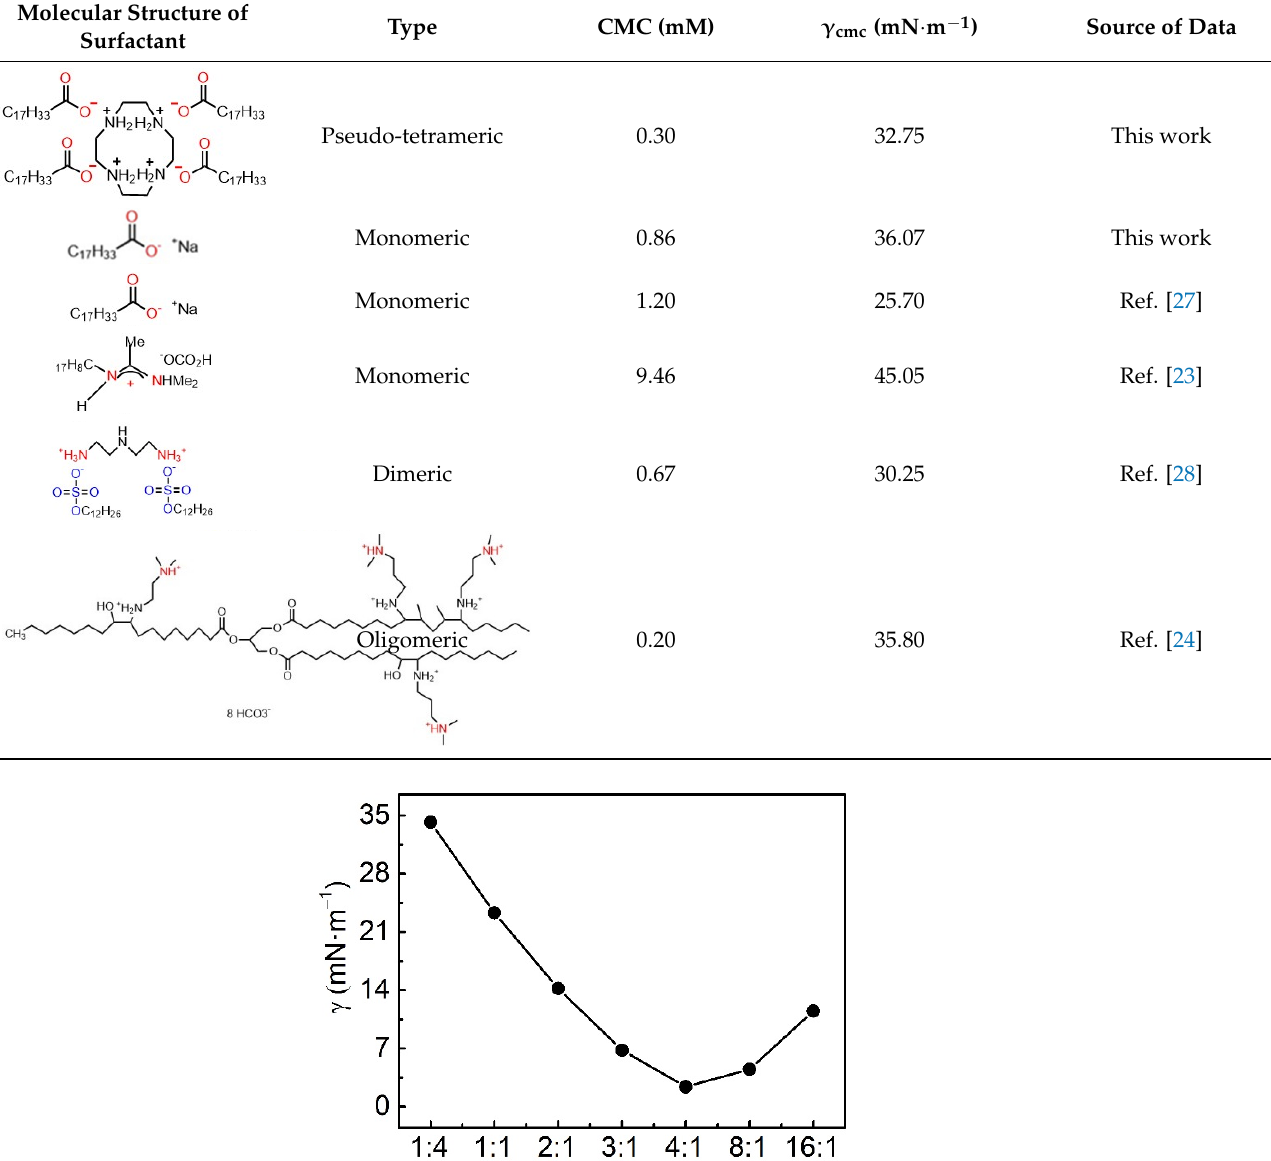
Table 1. Comparison of the surface properties of different CO 2 -switchable surfactants.